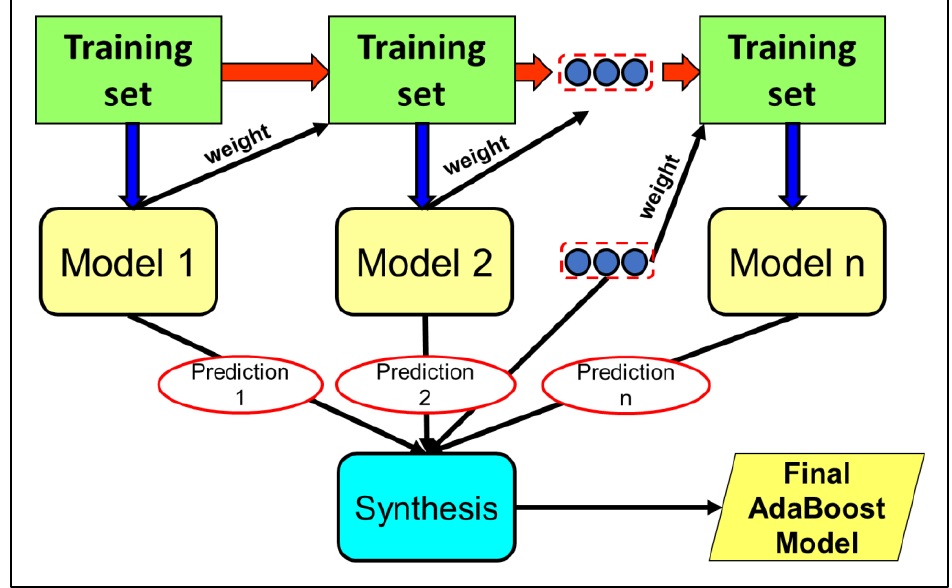
Figure 4. Schematics of AdaBoost [84].